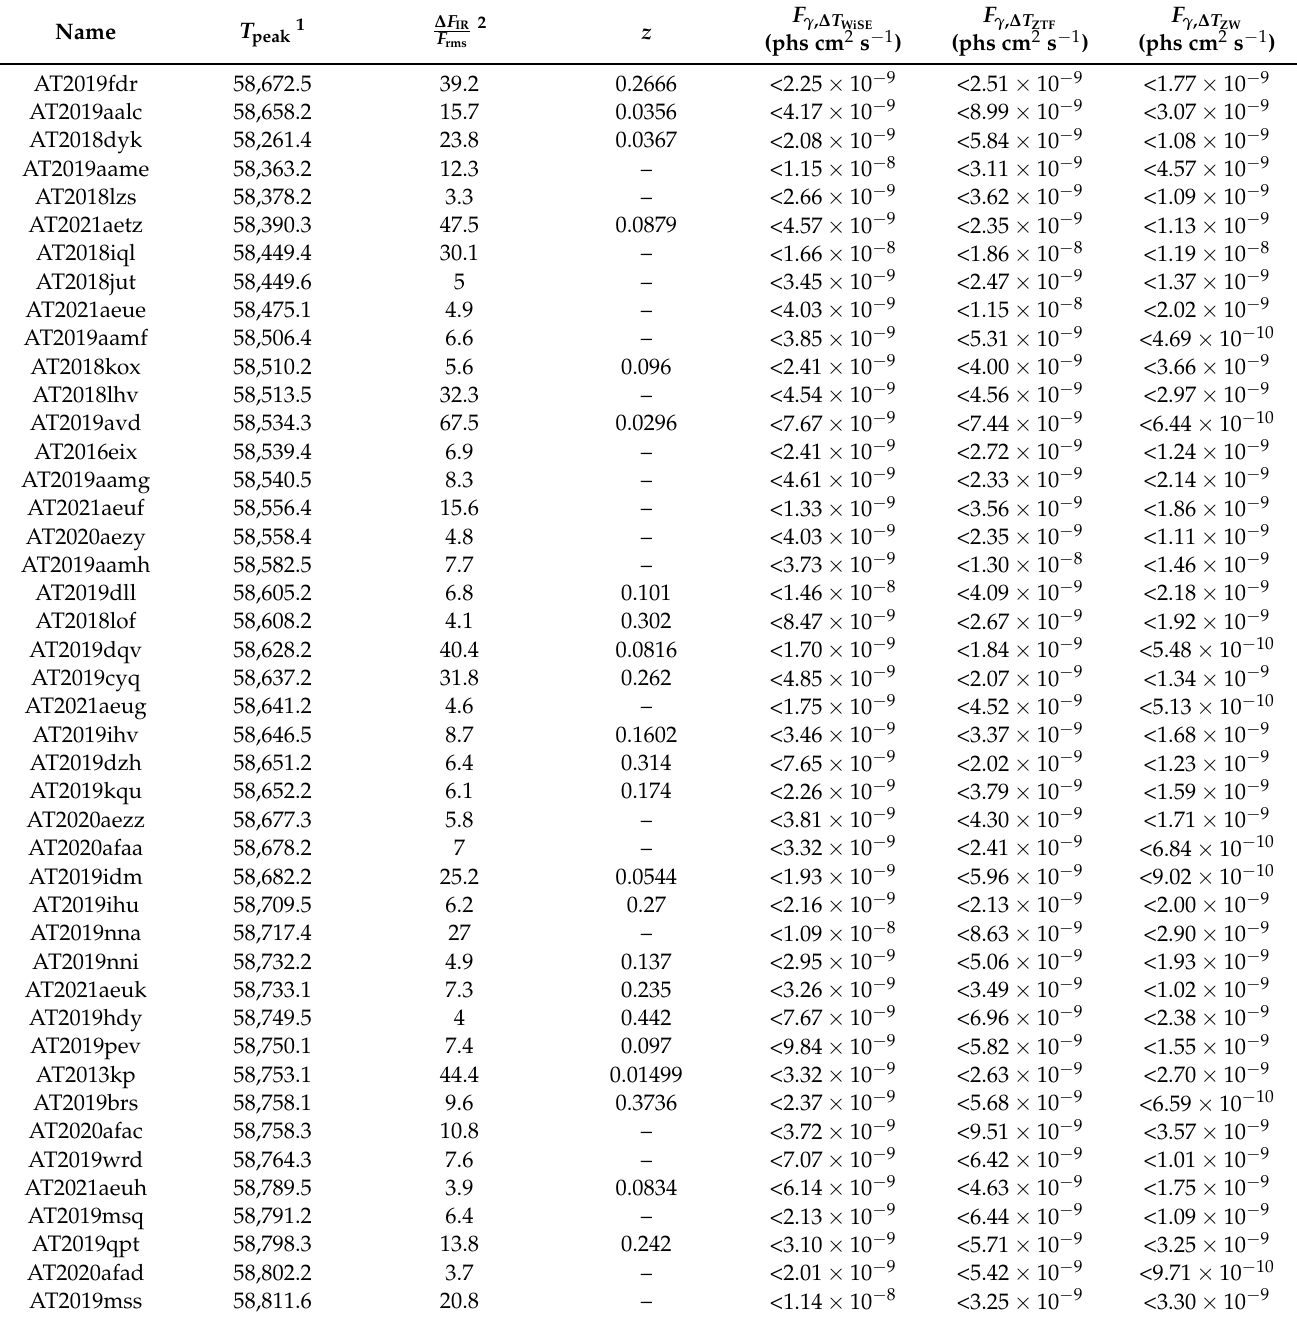
Table 1. Upper limits at 95% confidence level on gamma-ray flux of each source for different time